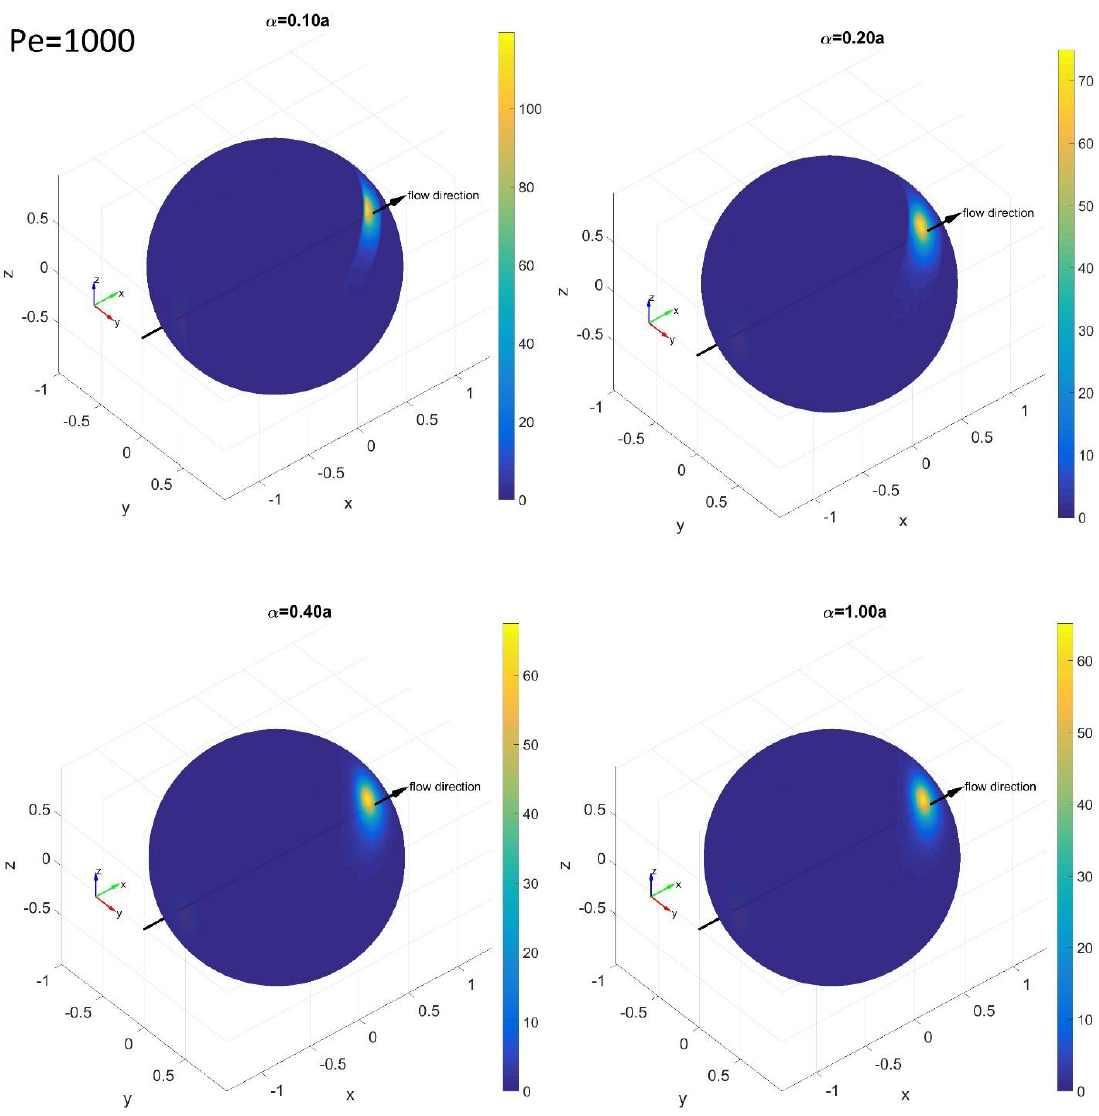
Figure 11. Simulation results for the PDF( θ , ϕ ) on the spherical surface of the tips of a rod at Pe = 1000 with α / a = 0.1, 0.2, 0.4 and 1.0. The color bars represent the probability density levels of each PDF from yellow (highest probability) to dark blue (lowest probability) (color online).